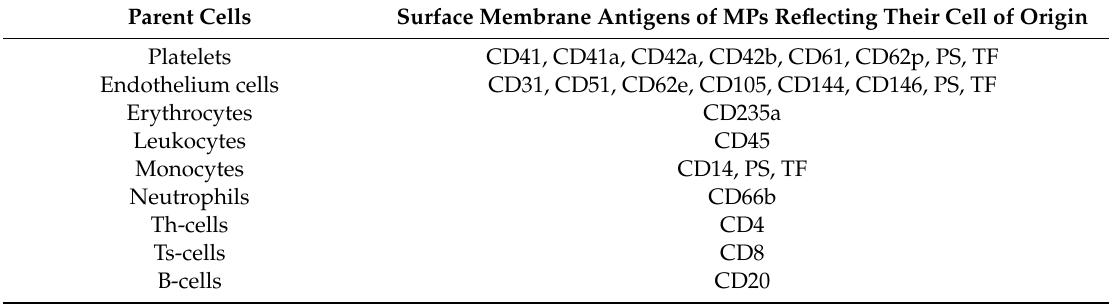
Table 1. Cells of origin of microparticles and their clusters of di ff